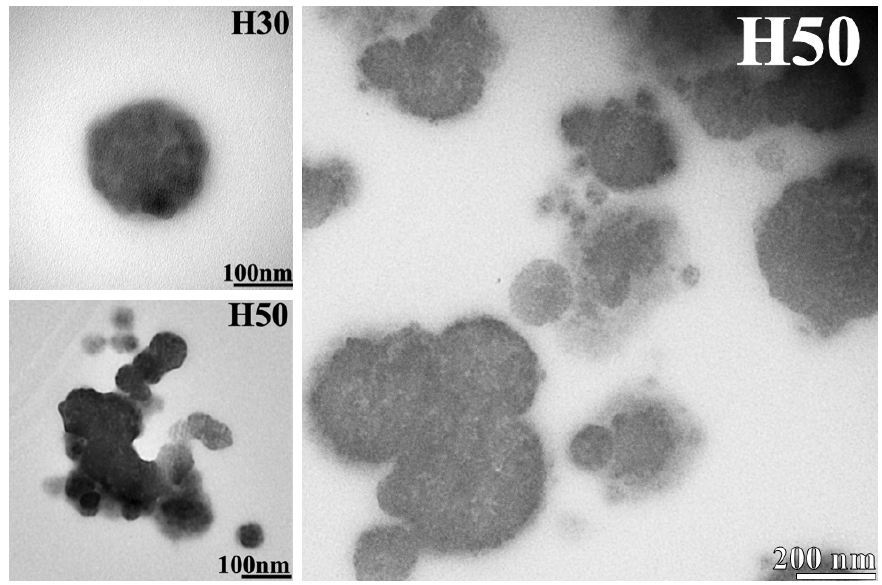
Figure 16. H30 and H50 transmission electron microscopy (TEM) micrographs at different magnifications.